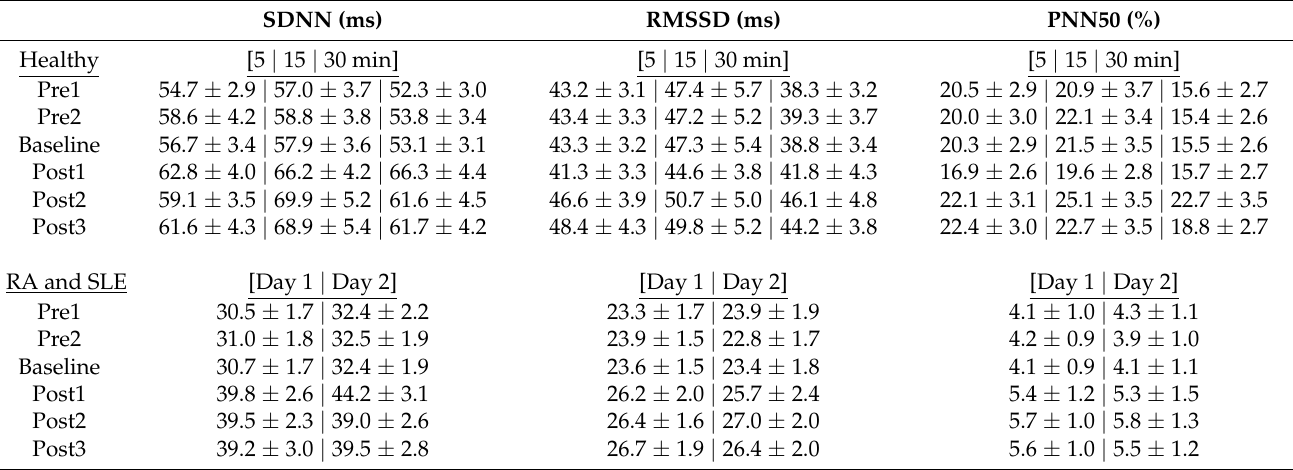
Table 4. Heart rate variability-parameters reported as mean ± standard error across subjects in the dose-response sub-study with healthy subjects and in the test-retest reliability study with RA and SLE patients. RA: Rheumatoid Arthritis. SLE: Systemic Lupus Erythematosus. SDNN: The standard deviation of the R-R intervals. RMSSD: The root mean square of successive R-R intervals. PNN50: The proportion of NN50 (pairs of successive R-R intervals that differ more than 50 milliseconds) divided by the total number of R-R intervals. Post1, post2, and post3 were performed at 0–5, 12.5–17.5, and 25–30 min after the deep breathing intervention,